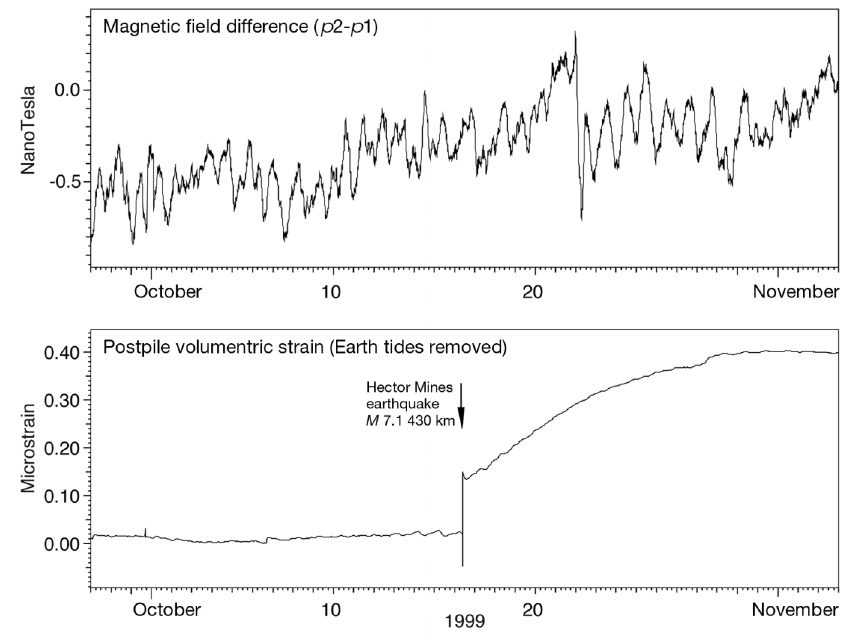
Fig. 7. Total intensity difference between two magnetometers (Unit in nT) at PLV in the upper curve and vol- umetric strain (Unit in µ -strain) in the lower one at POP site during the period from September 28 to November 3, 1999. Total intensity and strain were measured at every 10 min